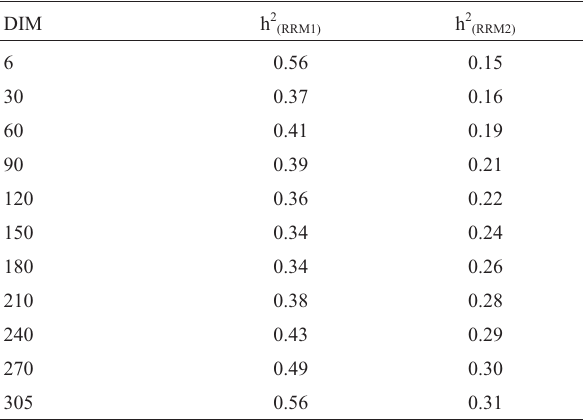
Table 7 - Estimates of heritability for selected DIM of daily yields ob- tained by the RRM1 and RRM2 models. DIM